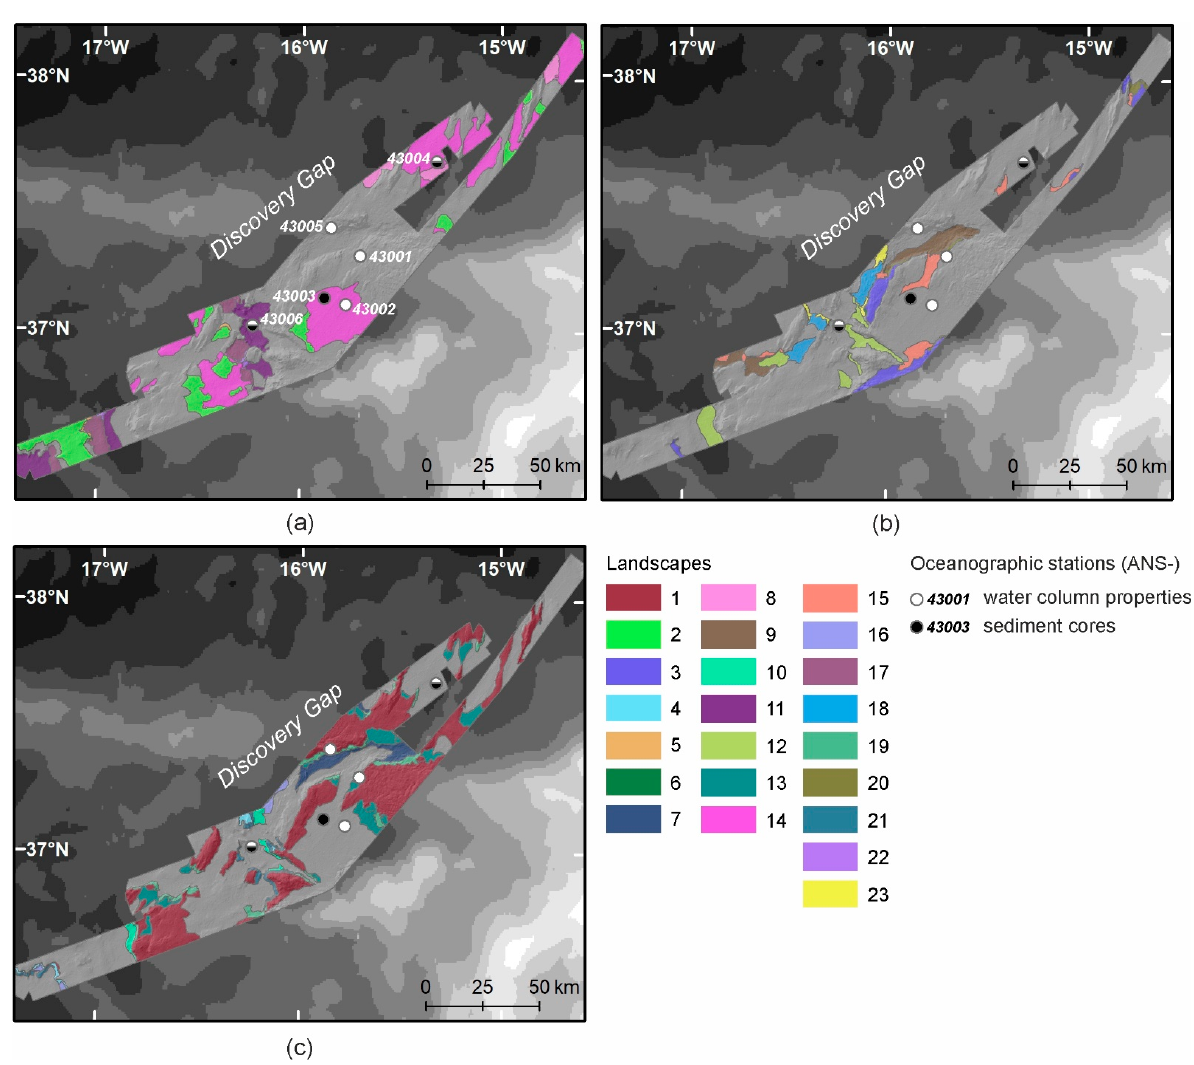
Figure 4. Seabed landscapes in Discovery Gap: ( a ) softground landscapes; ( b ) firmground landscapes; ( c ) hardground landscapes. For identification of the numbers see Table 3. Seabed landscapes resulted from the overlay of the BPI, substrate types, and water temper- ature. The percentage distribution of the landscapes in the area is marked by greyscale from high (dark grey) to low (white) values. Italian style highlights the landscapes with water temperature ≤ 2 °C.